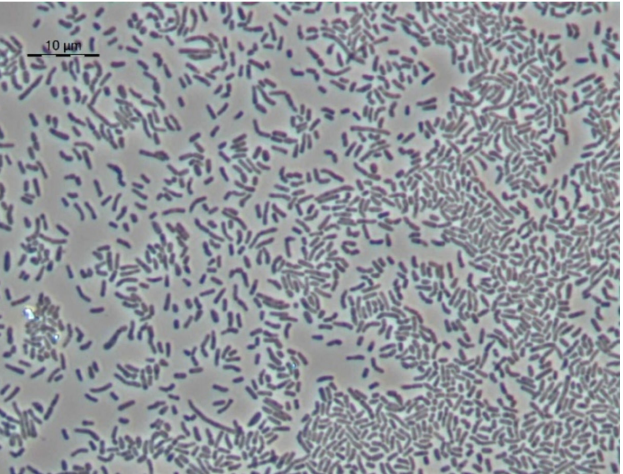
Figure 9. R. qingshengii strain VT6 on LB agar medium 1 month of growth. Light microscopy, phase contrast. The length of the scale mark is 10 µ